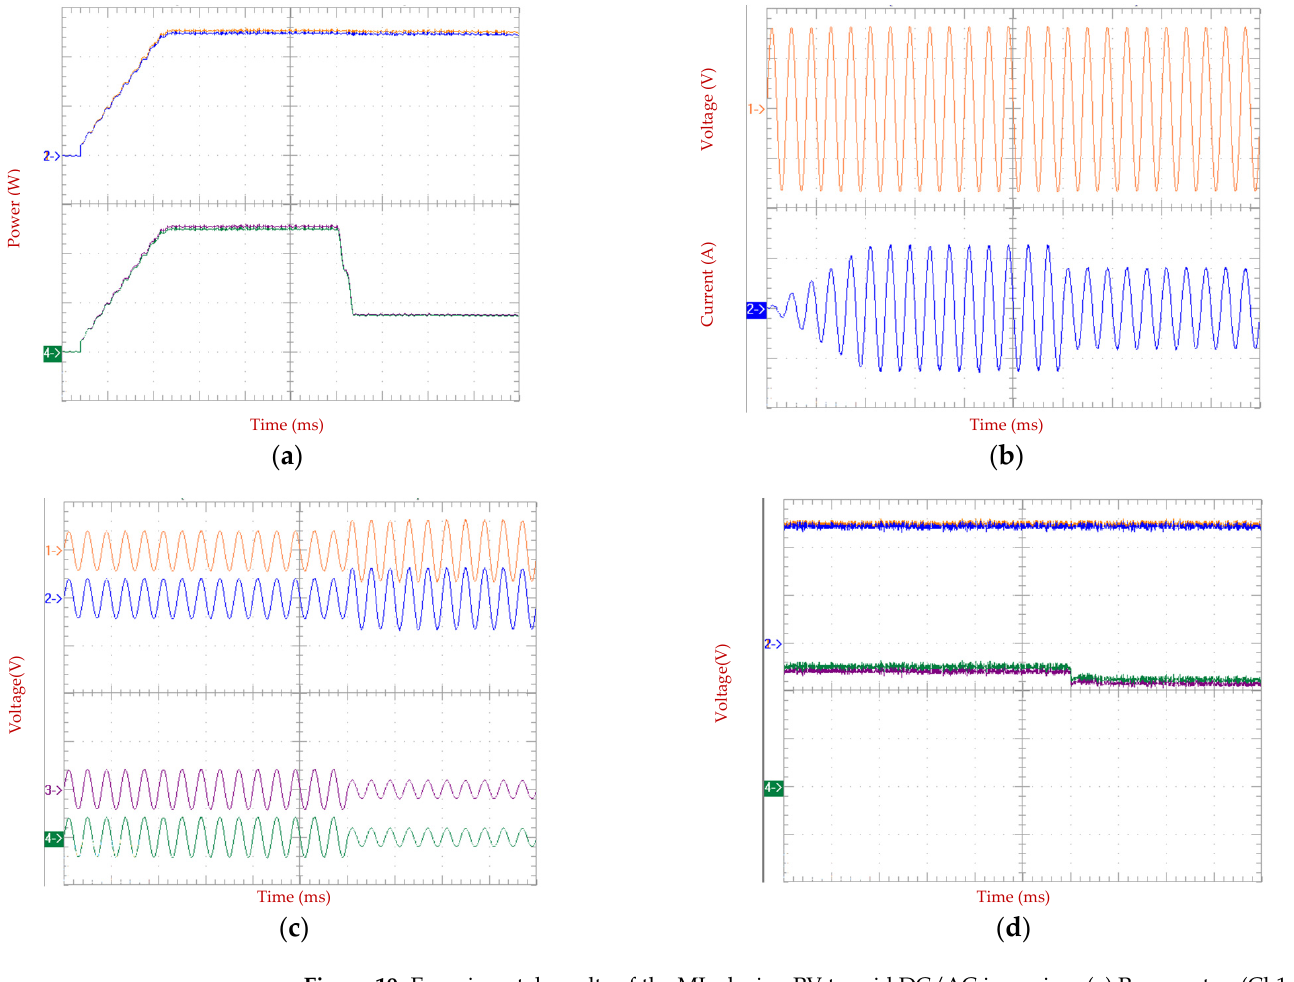
Figure 19. Experimental results of the MIs during PV to grid DC/AC inversion. ( a ) Powers: top (Ch1 and Ch2), MI 1 and MI 2 ; bottom (Ch3 and Ch4), MI 3 and MI 4 ; 50 ms/div–100 W/div. ( b ) Top (Ch1), grid voltage at PCC; bottom (Ch2), grid current; 50 ms/div–200 V/div–5 A/div. ( c ) Output voltages: top (Ch1 and Ch2), MI 1 and MI 2 ; bottom (Ch3 and Ch4), MI 3 and MI 4 ; 50 ms/div–200 V/div. ( d ) Input (power supplies) voltages: top (Ch1 and Ch2), MI 1 and MI 2 ; bottom (Ch3 and Ch4), MI 3 and MI 4 ; 50 ms/div–20 V/div.